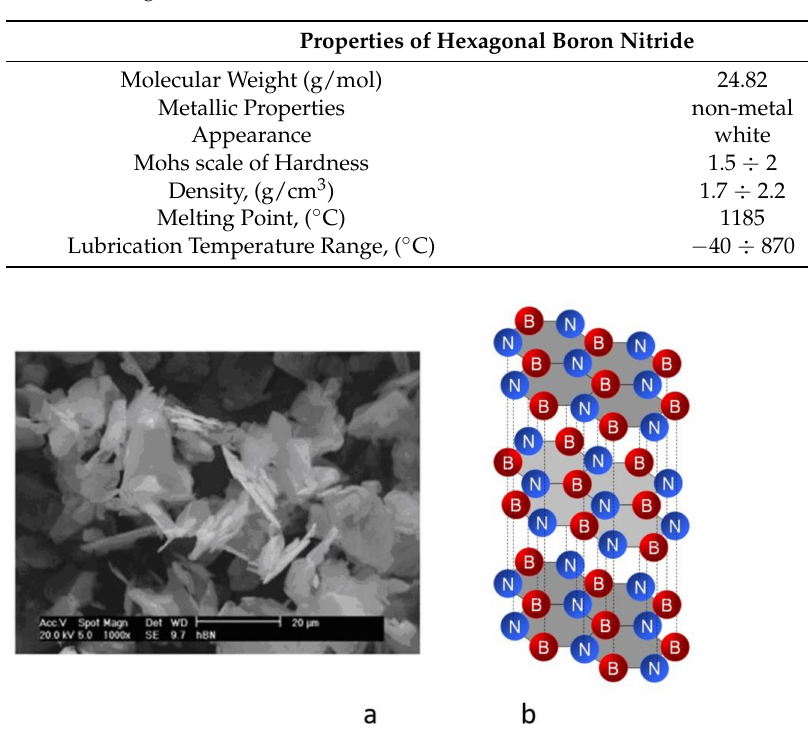
Table 2. Hexagonal boron nitride.